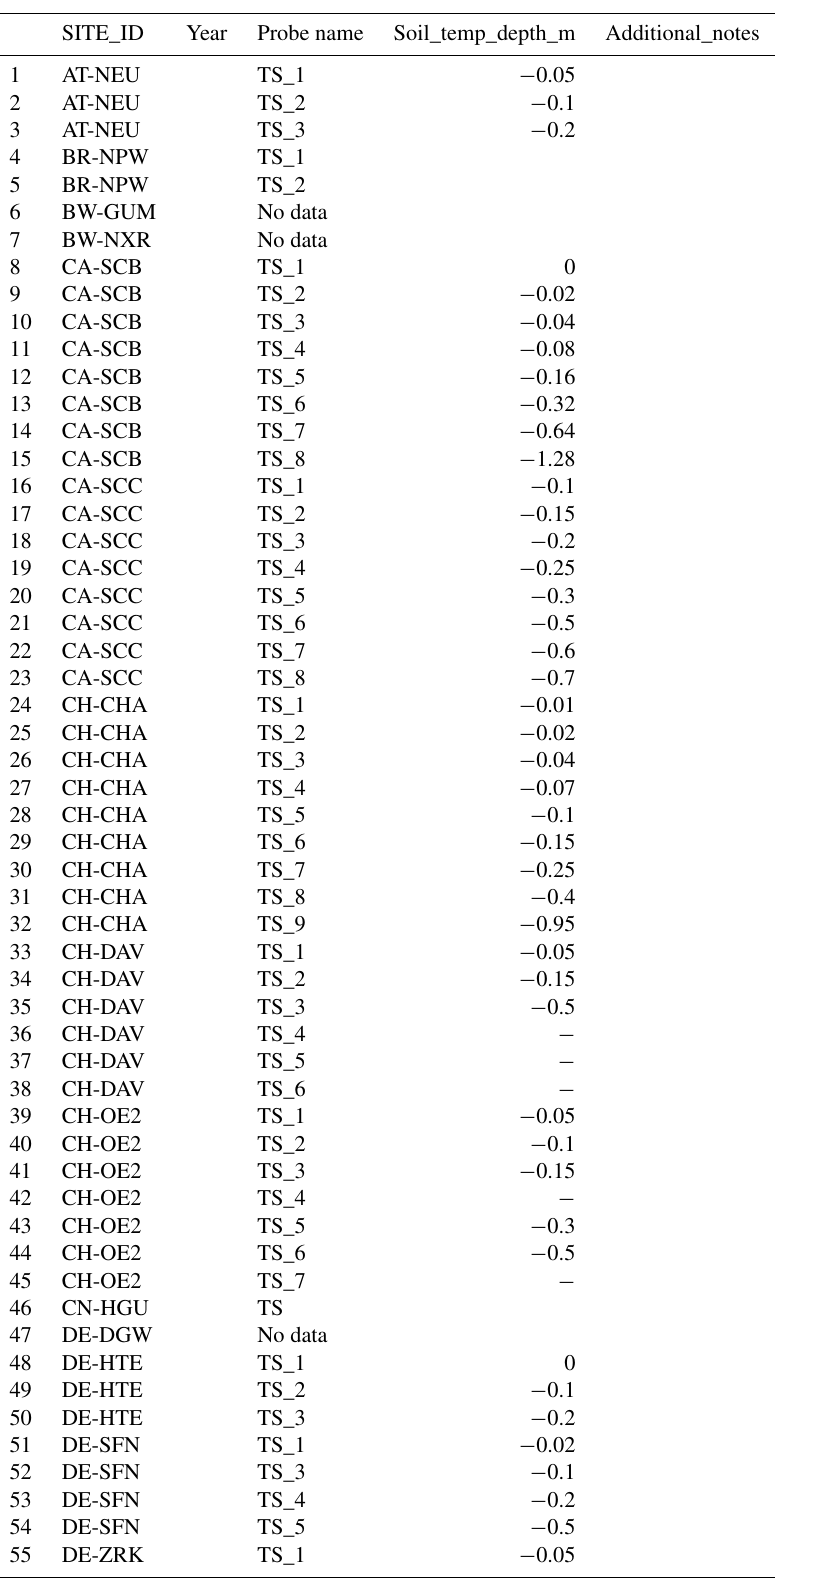
Table B7. Installation depths for soil temperature